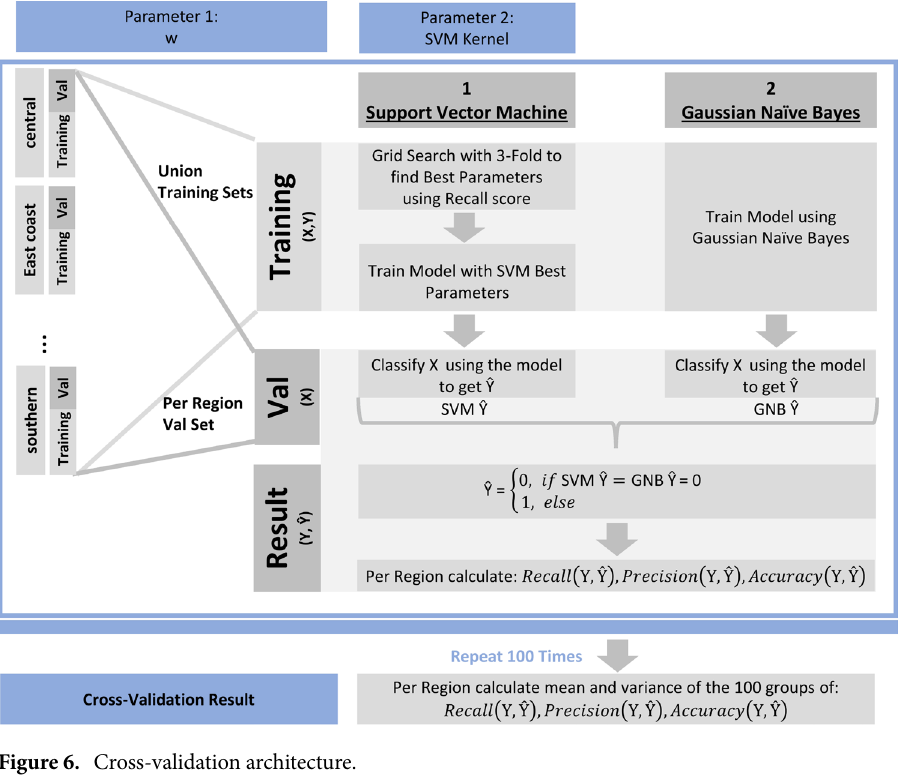
Figure 6. Cross-validation